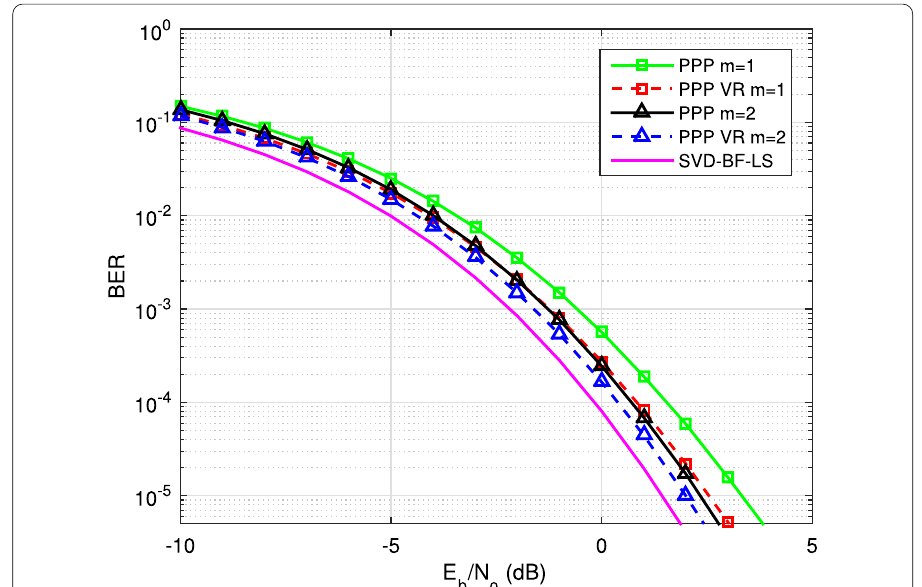
Fig. 7 Simulated BER for PPP with beamforming vector re-estimation (VR) at forward Pong stage compared to the Ping – Pong – Pong base case and the ideal SVD beamforming with LS-estimated channel (SVD-BF-LS)